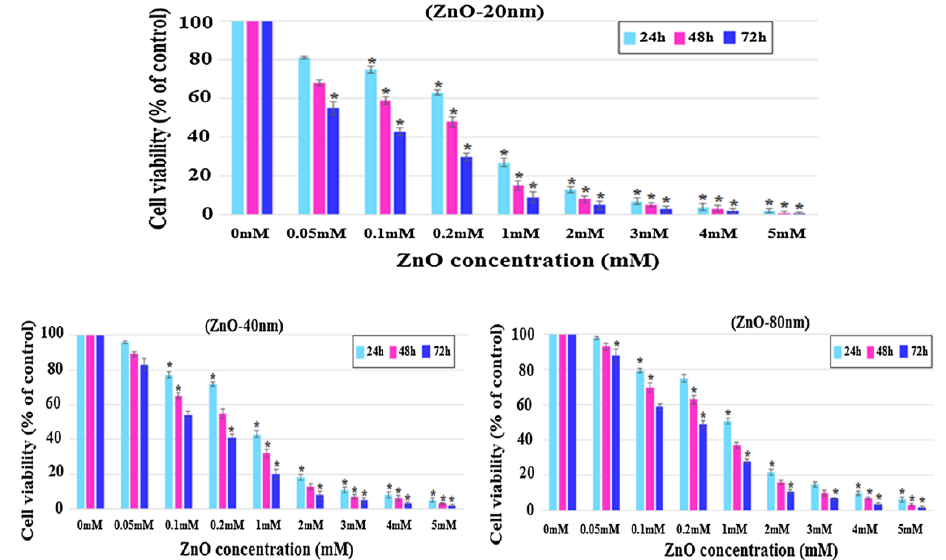
Figure 29. Cell viability of HeLa cancer cells treated with ZnO NPs of different sizes and doses for 24, 48 and 72 h. Results are presented as mean ± standard deviation of three independent experiments. * p < 0.05. Reproduced from [144] with permission of Springer Nature. Table 1. Toxic effects of ZnO nanostructures to normal mammalian cells and cancer cells. ZnO Dose & Exposure Shape & Size Cell Type Cytotoxic Effect Ref. Time Normal cells Polygonal nanoparticles (NPs); 55 nm